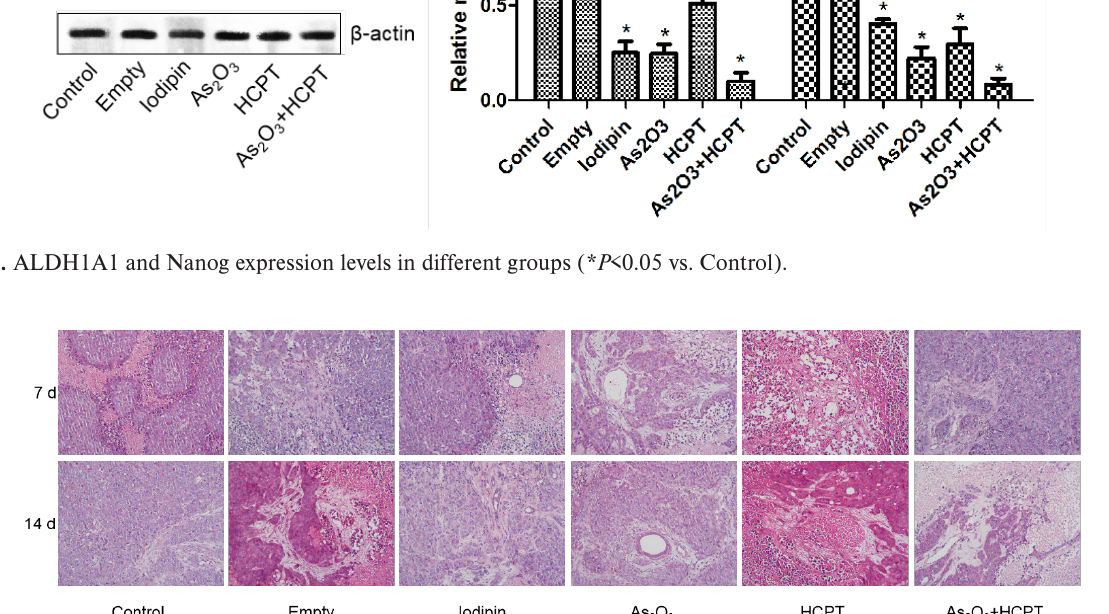
Fig. 3. HE staining detection of the effects of combined embolization of PLGA microspheres loaded with HCPT and As liver tissues (200×).